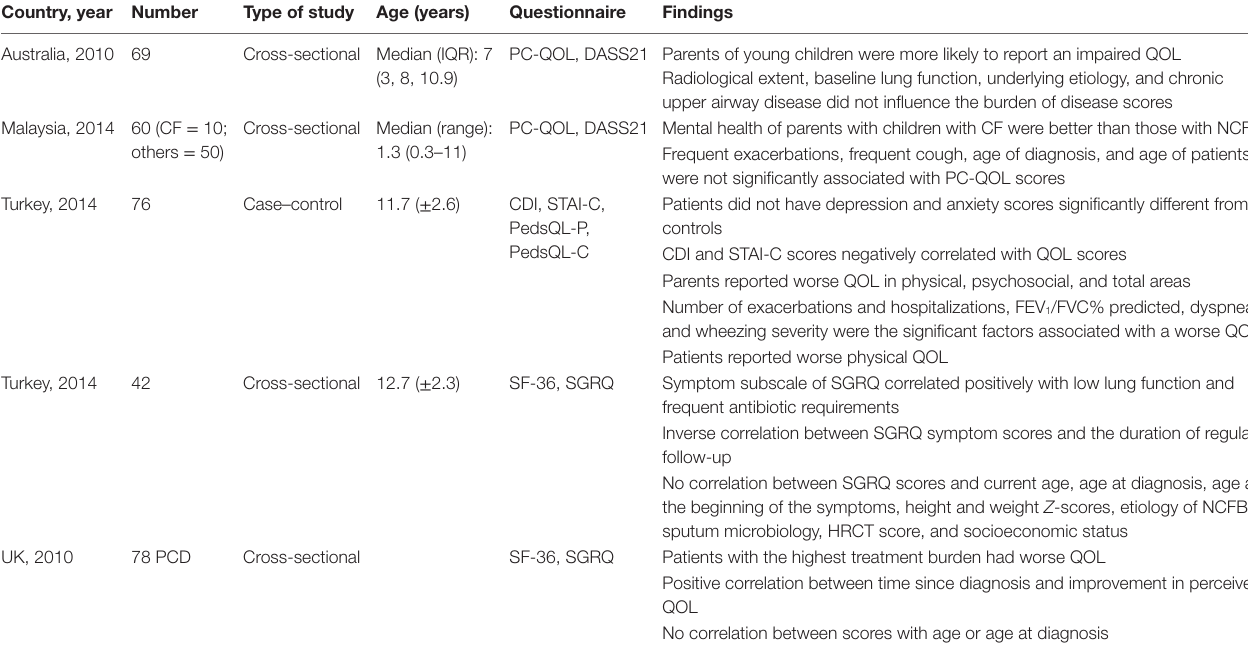
TABLe 1 | Summary of studies and their findings of quality of life (QOL) in children with non-cystic fibrosis bronchiectasis (NCFB). Country, year